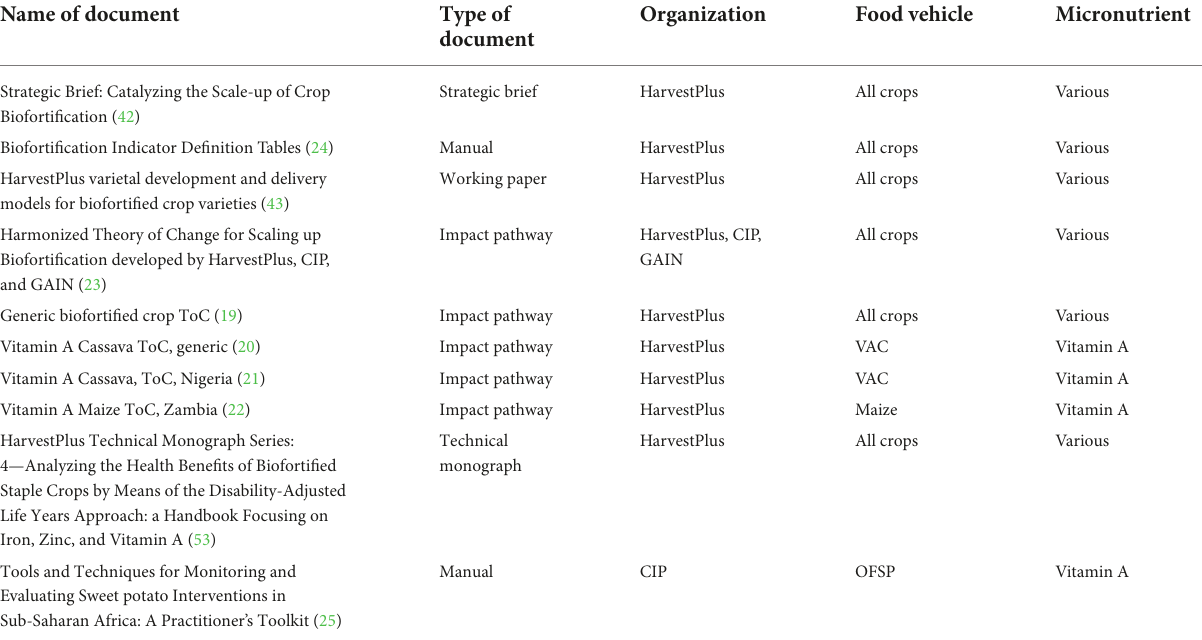
TABLE 3 List of additional documents received from SSI participants from HarvestPlus and